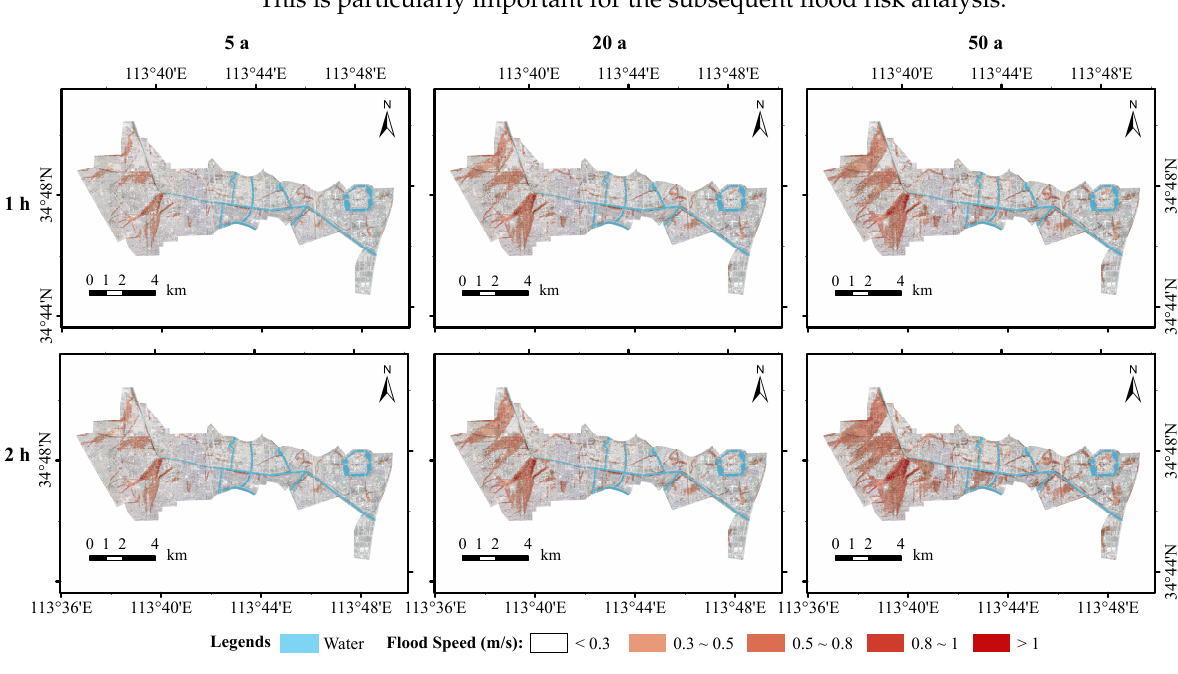
Figure 7. Simulated flood flow